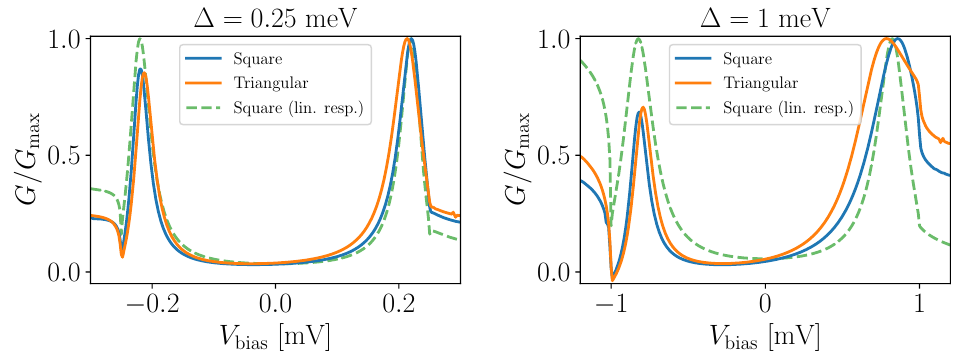
Figure 7: (a) Normalized finite-bias and linear-response conductances of systems = 0 and (a) ∆ = 0.25 meV and with a square barrier and triangular barrier at V Z (b) ∆ = 1 meV (blue lines). Adding finite-bias effects breaks particle-hole symmetry of the linear response conductance (green dashed lines). A triangular tunnel barrier amplifies the width asymmetry of the peaks (though their height does not change sig- nificantly) because the effective barrier at positive voltages is smaller than at negative